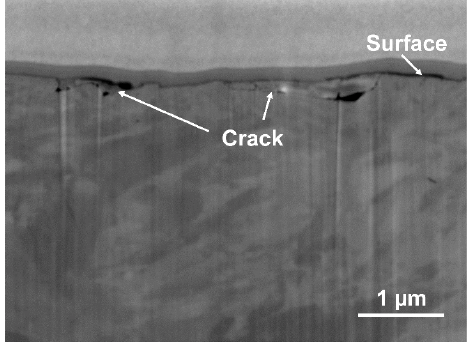
Fig. 11 Cross-sectional SEM image of disc after testing for 846 m at 400